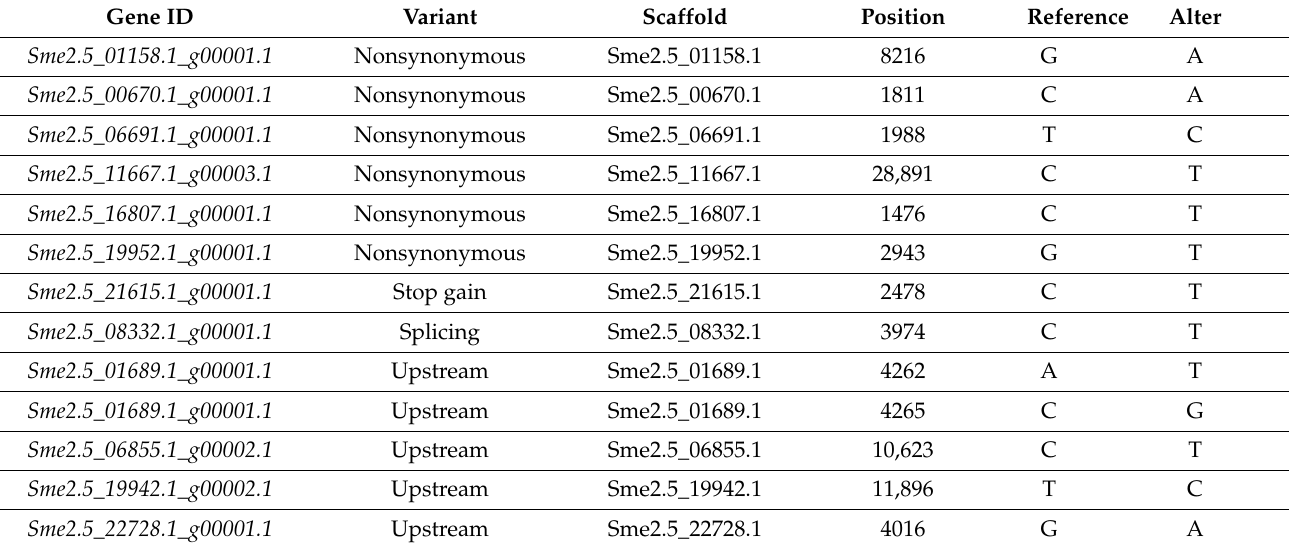
Table 3. Candidate SNP sites. Gene ID Variant Reference